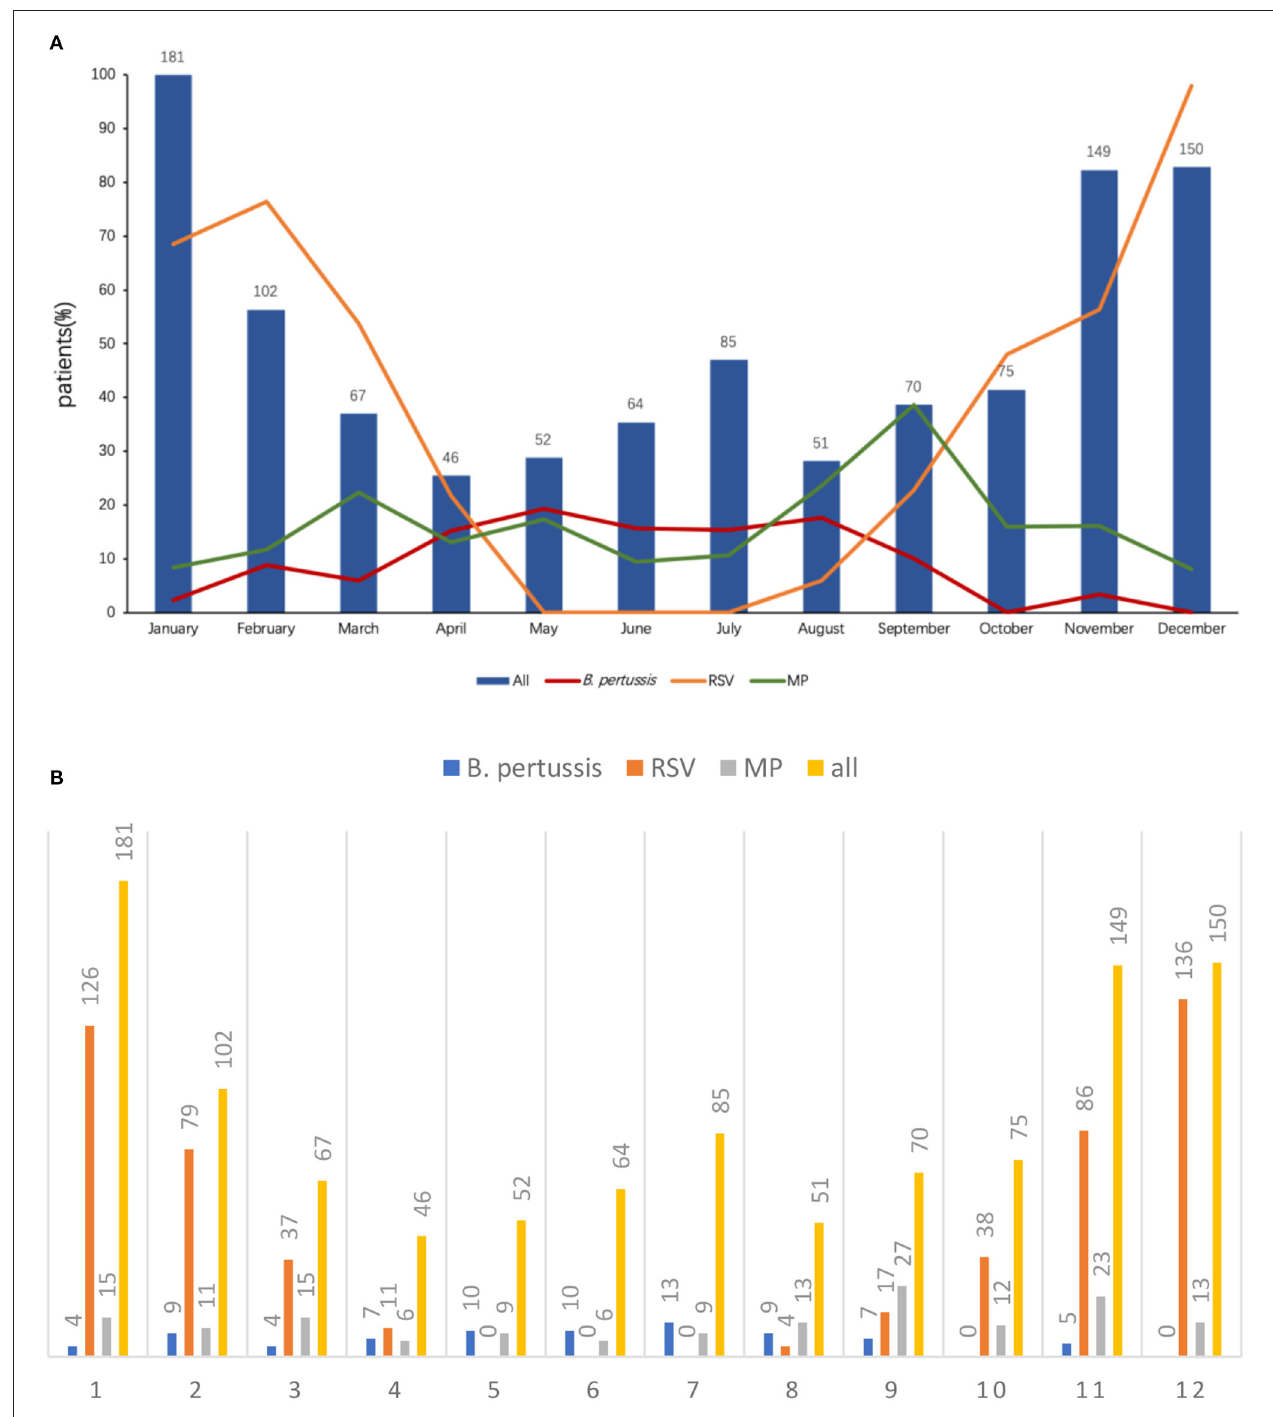
FIGURE 2 | (A) Distribution of B. pertussis and other pathogen infection by month. (B) Distribution of B. pertussis and other pathogen infection by month.